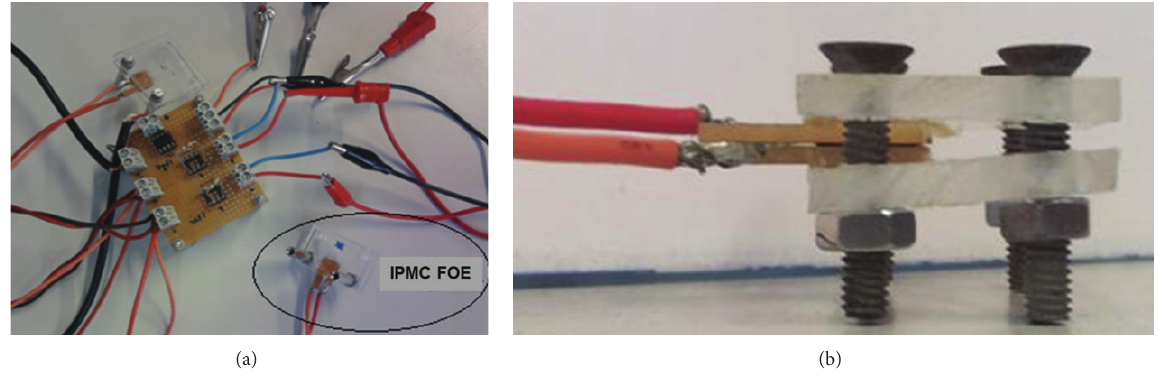
Figure 4: (a) Experimental setup. (b) IPMC FOE setup.